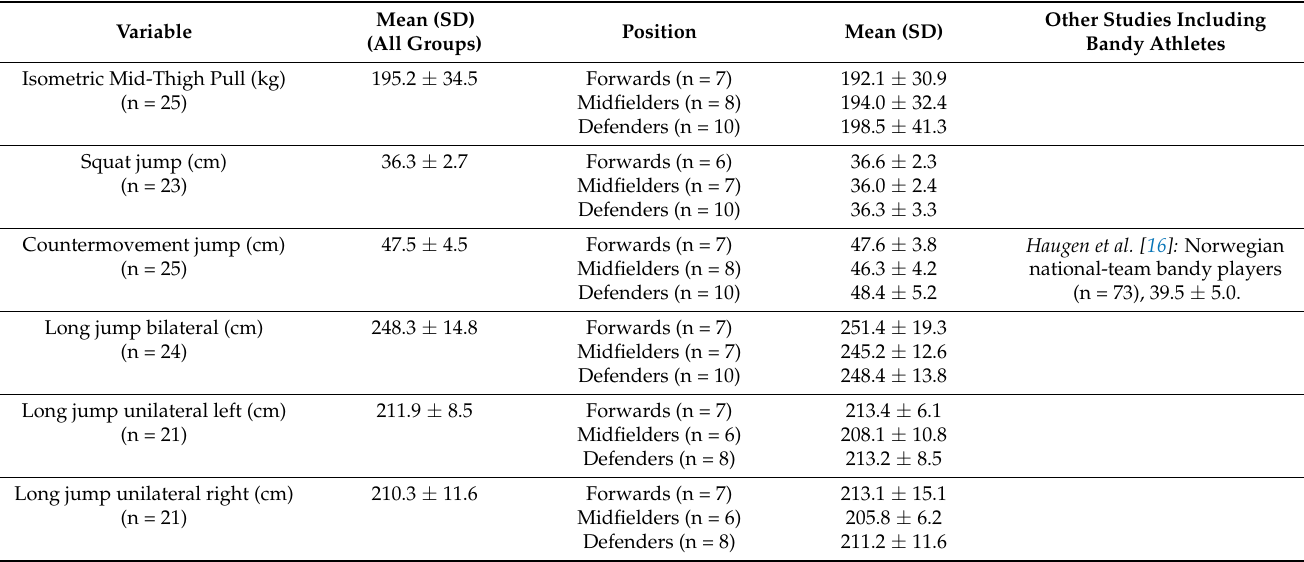
Table 2. Strength and jump characteristics of the participants.